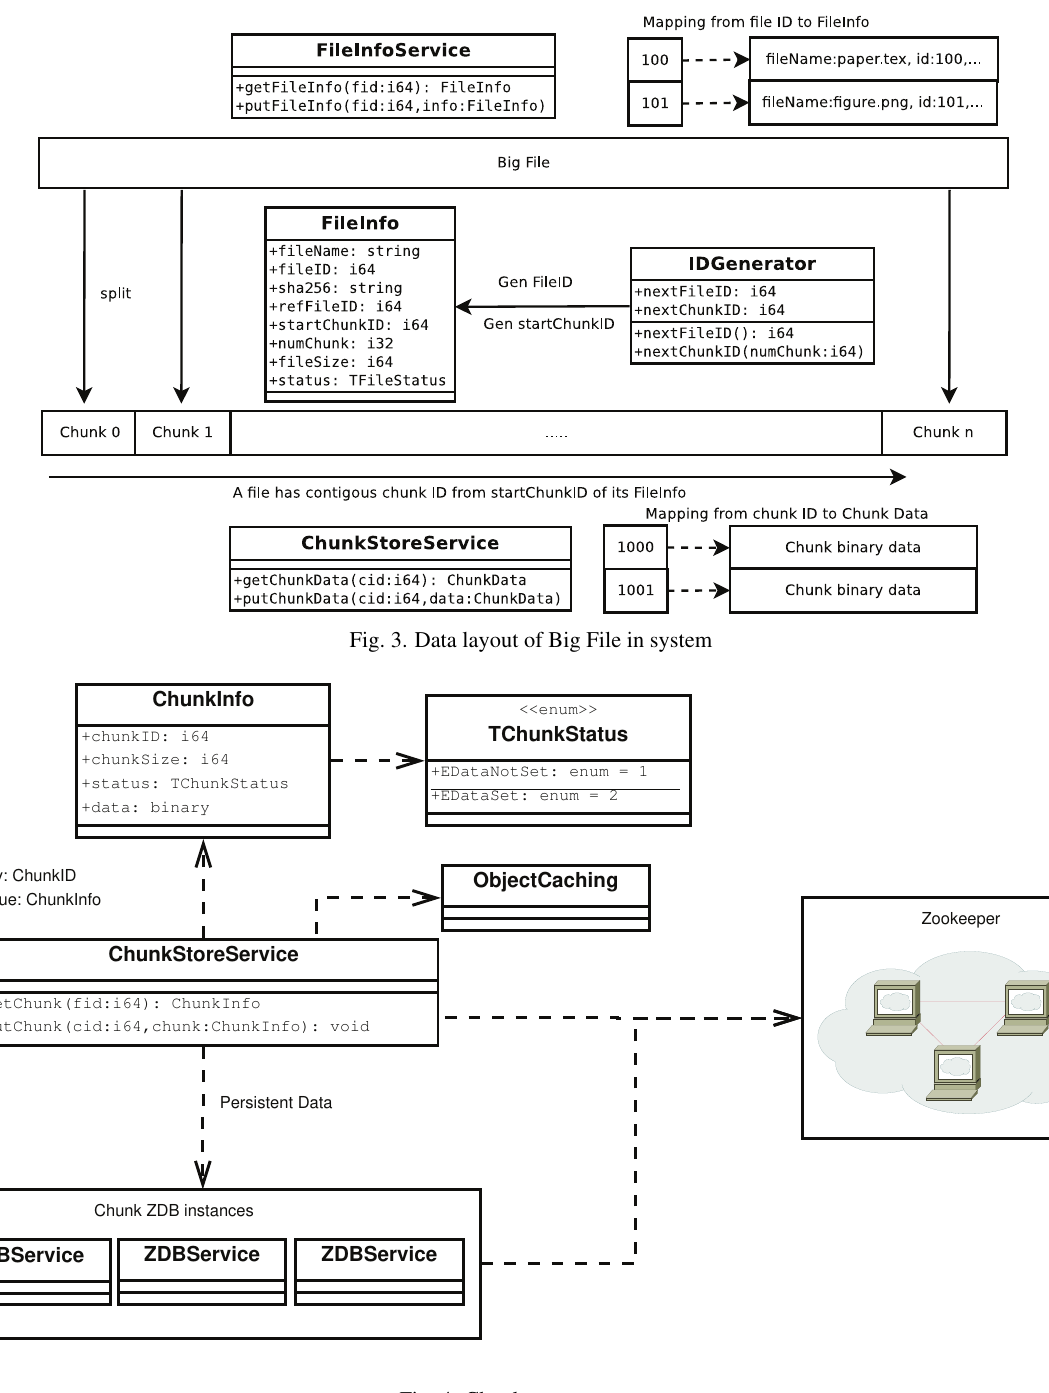
Fig. 4. Chunk storage